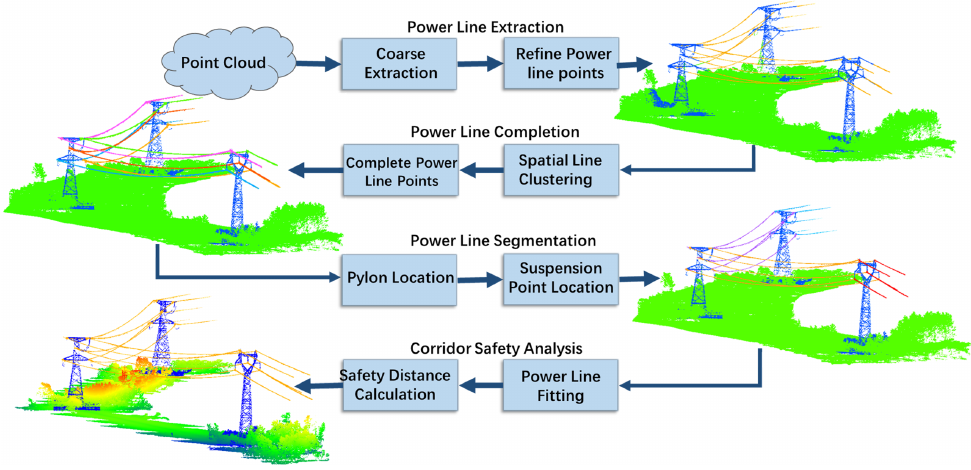
Figure 1. Overview of the